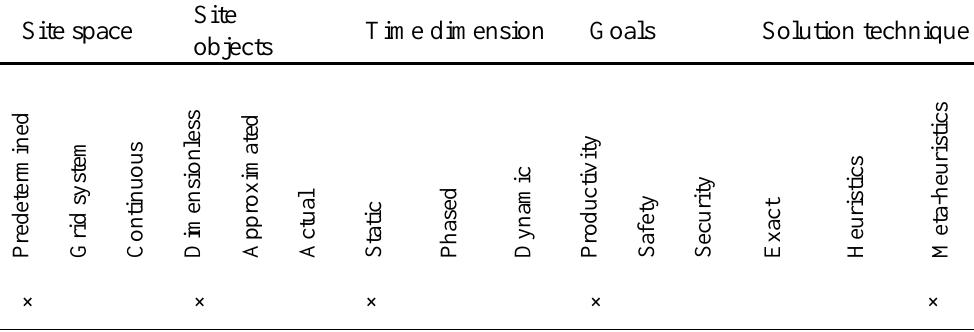
Table 1. The features of the problem of our